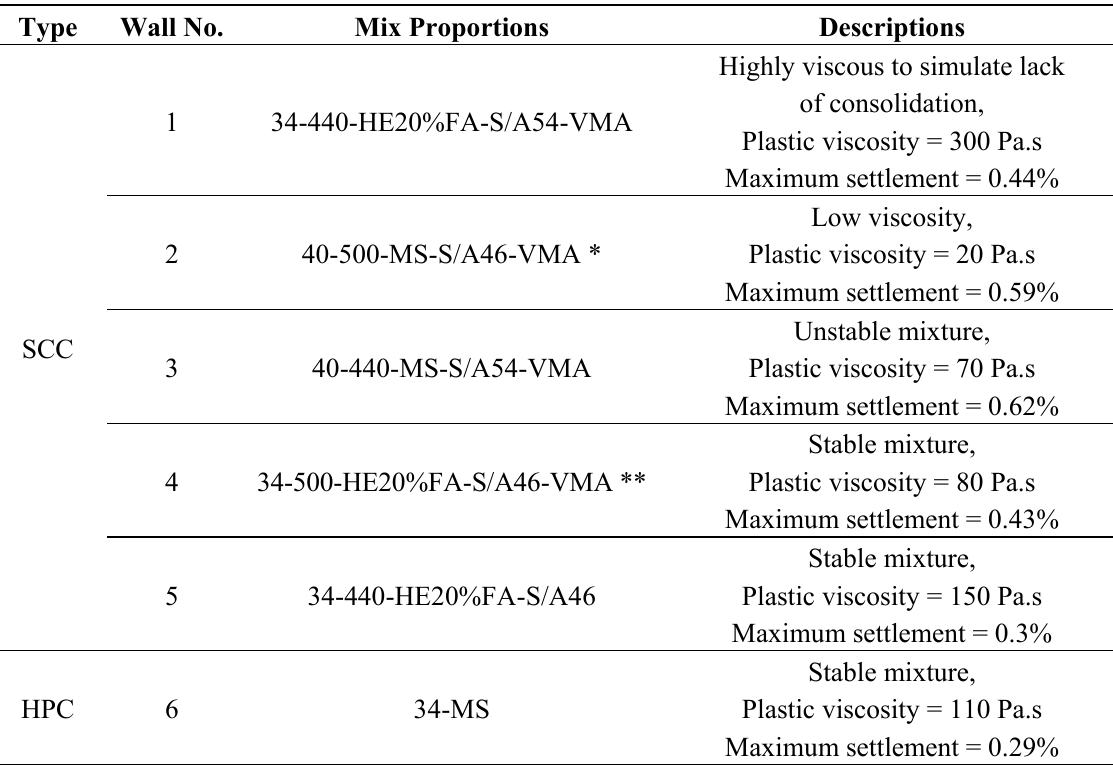
Table 1. Selection of self-consolidating concrete (SCC) and high-performance concrete (HPC) mixtures for strand bond